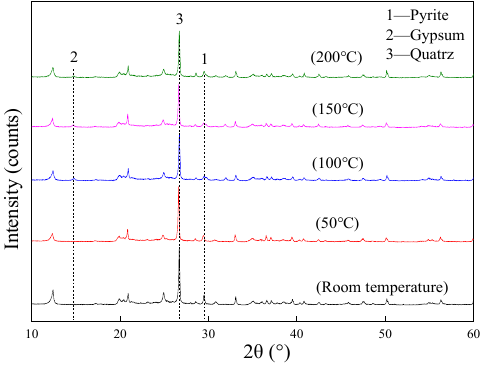
Figure 6. XRD patterns of the remaining coal gangue at different temperatures.